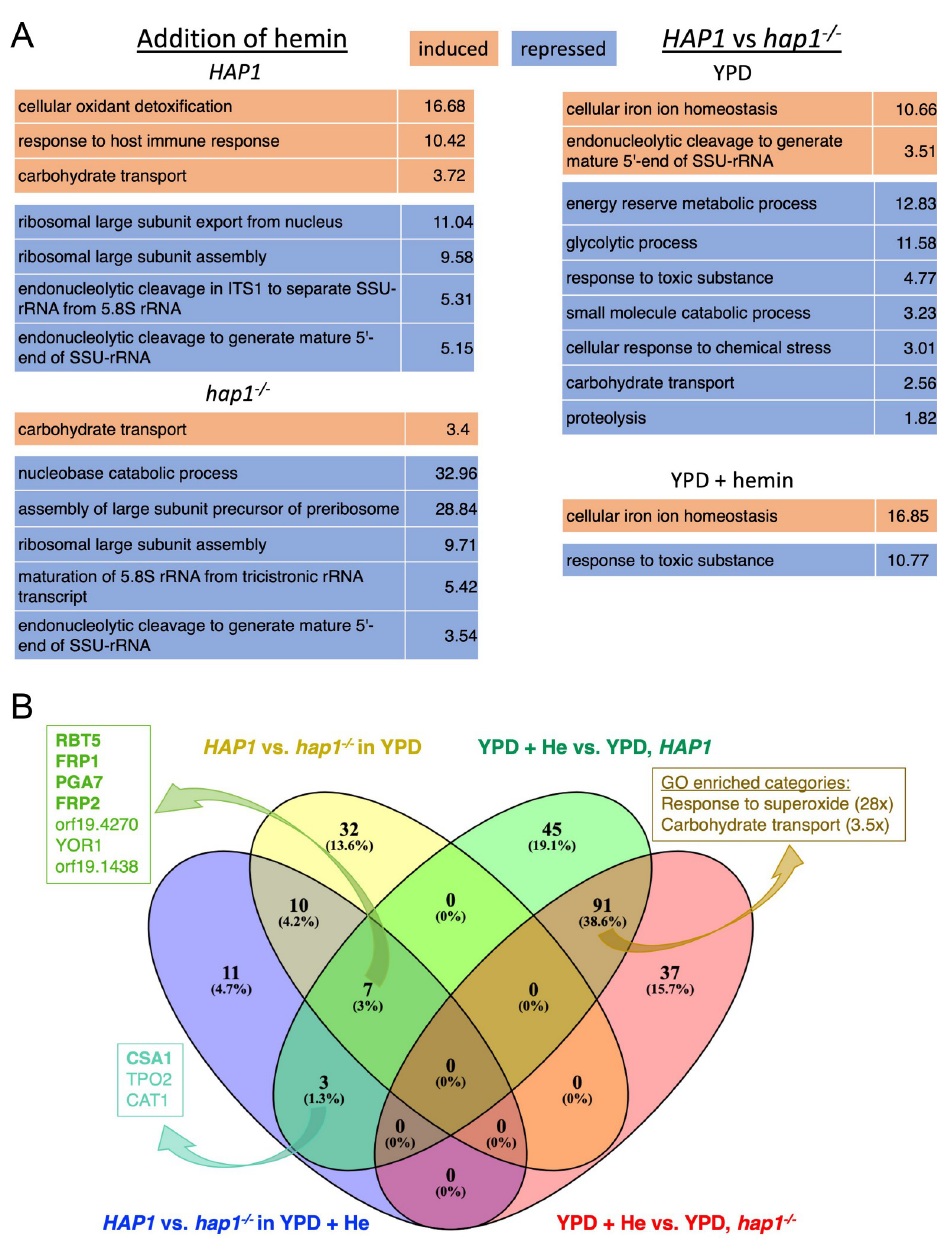
Fig 6. Analysis of genes regulated by hemin vs. genes regulated by Hap1. (A) GO analysis of genes induced or repressed at least 2x in all comparisons showed. Only the top term in the GO hierarchy is shown. Full lists are available in S4 and S5 Tables. (B) Venn diagram of overlap of genes induced at least twice. The four groups are: genes induced at least 2-fold in HAP1 vs. hap1 -/- in the presence of hemin (violet) or in regular medium (yellow) and the genes induced at least 2-fold by hemin in the HAP1 strain (green) or in the hap1 -/- strain (pink orange). The boxes on the left give the names of the seven genes induced by hemin and by HAP1 with or without hemin (dark green), and by hemin and by HAP1 in the presence of hemin only (turquoise). CFEM hemophores and ferric reductase-like genes FRP1 , FRP2 are in bold. The box on the right lists the enriched GO categories of genes overexpressed in the presence of hemin in both HAP1 and hap1 -/- cells. The full lists of the genes in each of the populated categories are shown in supplementary S2